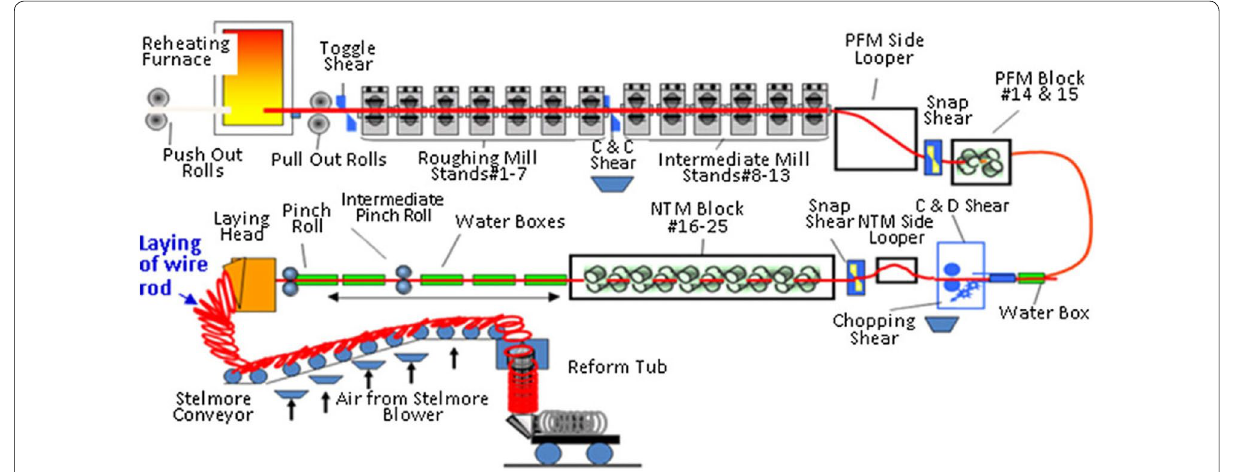
Figure 1 Schematic layout of process flow in a wire rod mill